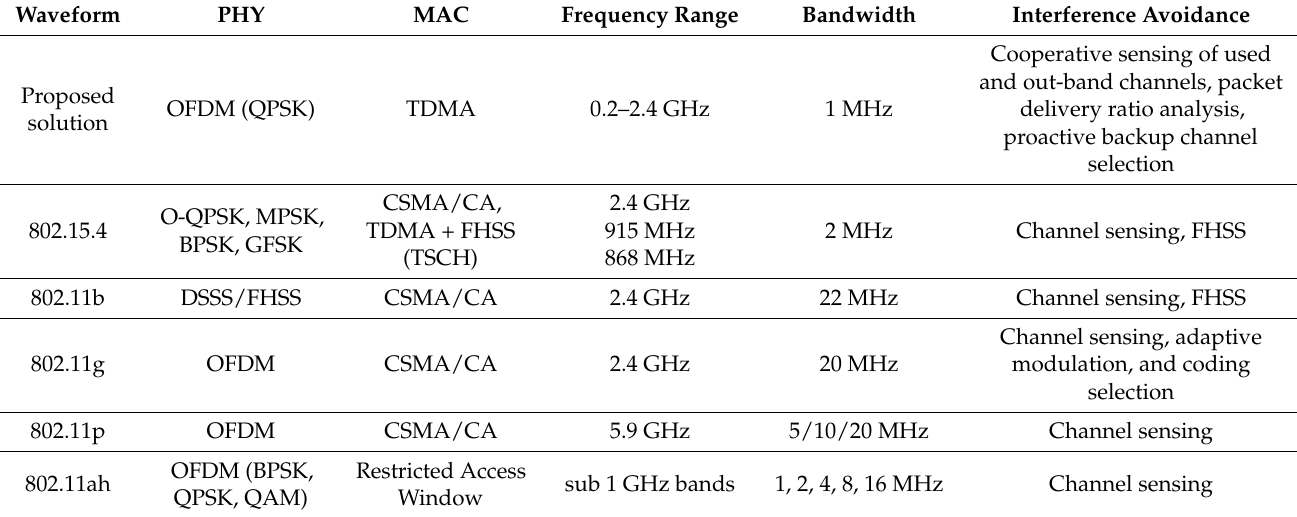
Table 2. Comparison of the proposed solution with relevant